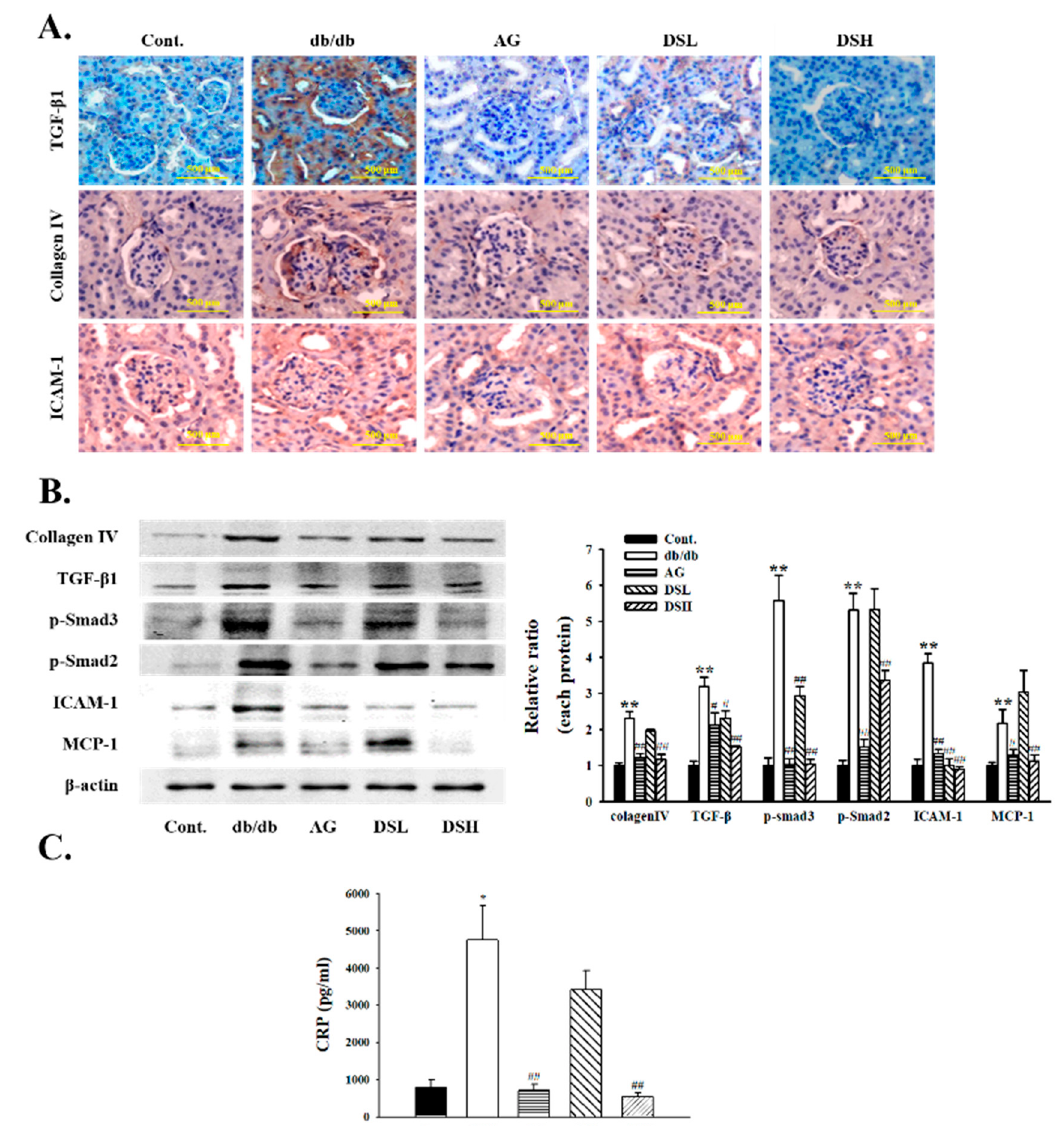
Figure 6. Effect of DS-EA on glomerular fibrosis in the cortex of kidney tissues. ( A ) Immunohistochemistry detected that DS-EA therapy inhibited TGF β 1, collagen IV, and ICAM-1 expression in the diabetic kidney of db/db mice ( n = 3, magnification 400 × ). ( B ) Expression of protein in mouse kidneys was determined by western blot analysis ( n ≥ 3). ( C ) Plasma C-reactive protein (CRP) levels were measured at wavelengths of 450 nm using an ELISA reader. Values are expressed as mean ± S.E. ( n = 8). * p < 0.05, ** p < 0.01 vs. Cont.; # p < 0.05, ## p < 0.01 vs. negative Cont.; Cont.: db/m mice group; db/db: db/db mice group (negative Cont.); AG: db/db mice treated with aminoguanidine group; DSL: db/db mice treated with low-dose DS-EA group; DSH: db/db mice treated with high-dose DS-EA